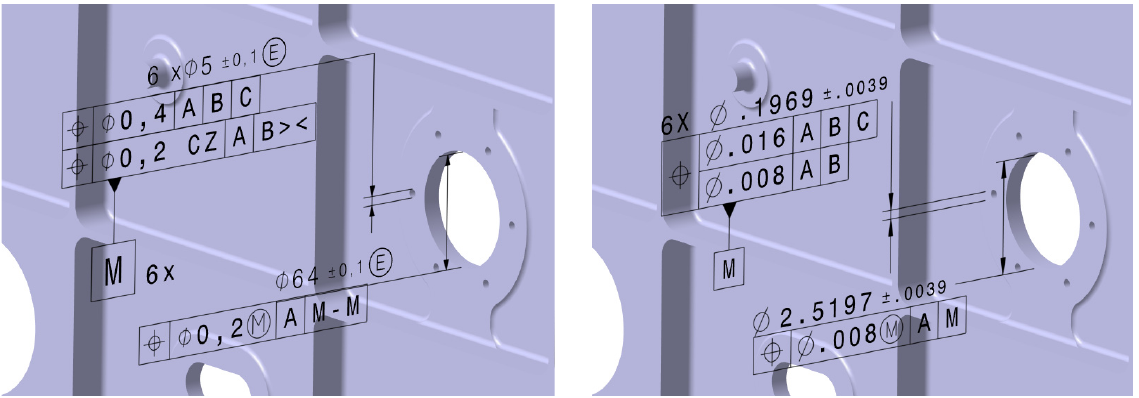
Figure A7. Satellite hole pattern in ISO model ( left illustration) and Flange holes in ASME model ( right illustration).